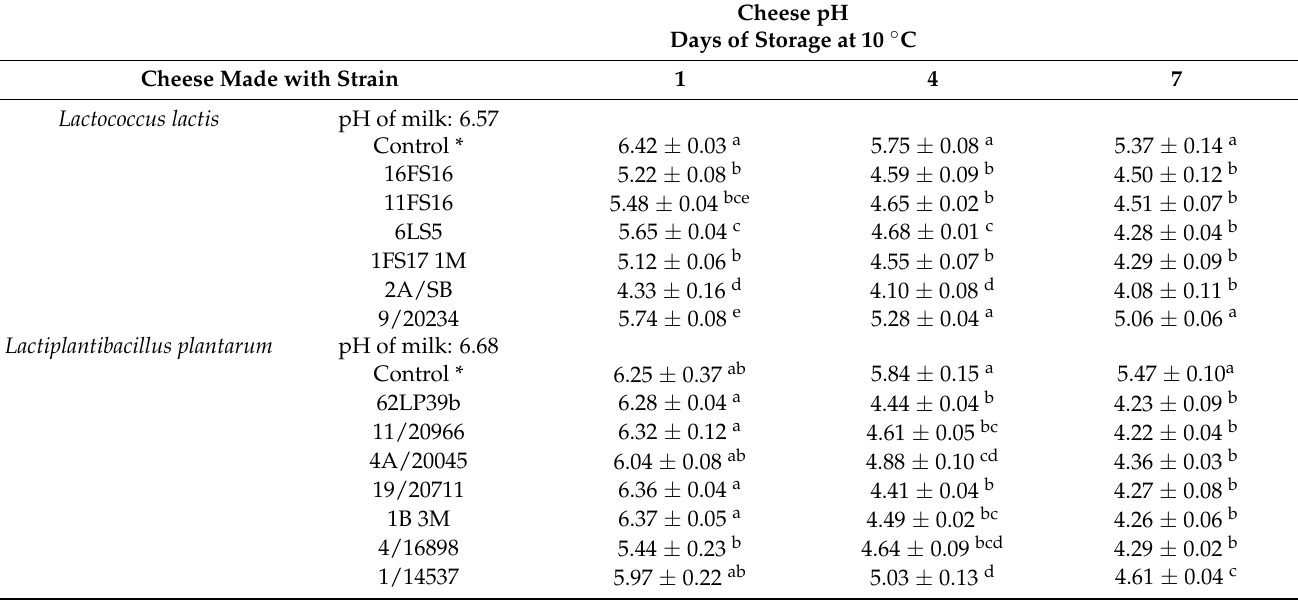
Table 3. pH of cheeses measured at 1, 4 and 7 days of storage at 10 ◦ C after inoculation with L. monocytogenes ATCC 7644 and each LAB strain (means ± SD of two replicates for each sample). Cheese pH Days of Storage at 10 ◦ C Cheese Made with Strain 1 4 7 Lactococcus lactis